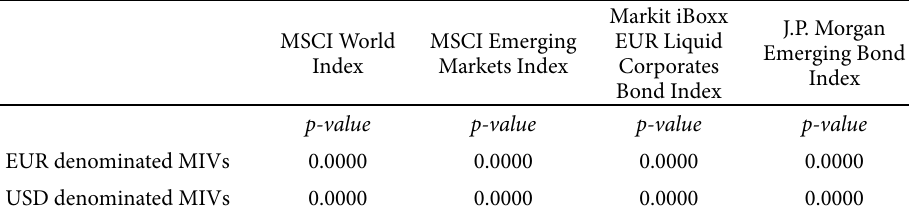
Table 7. Mean-variance Spanning test for MIVs over benchmark